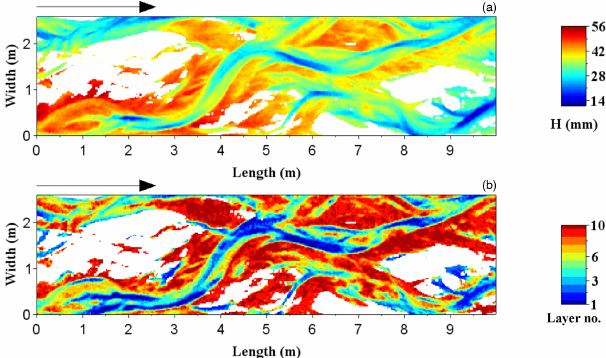
Figure 7. The bed elevation is normalized by the morphological active layer thickness. On initial topography (a) , local topographic gradients affect local elevation of features. On normalized topog- raphy (b) , equivalent features all have elevation shown by the same range of color over the model extent; for example, channels are blue and high bar tops dark red. The flume slope is